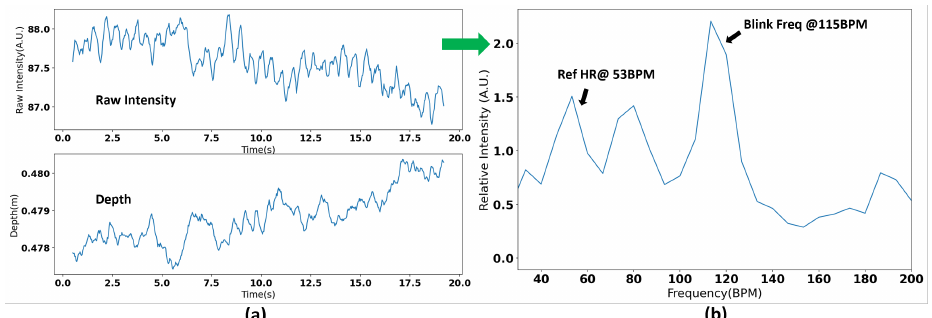
Figure 21. Periodic reflection from participant blinking could affect the location of the ROI-1 as a result of jitter. The jittering can lead to additional intensity artifacts that will not be captured by the ( a ) depth signal, leading to erroneous HR reading from the ( b ) frequency